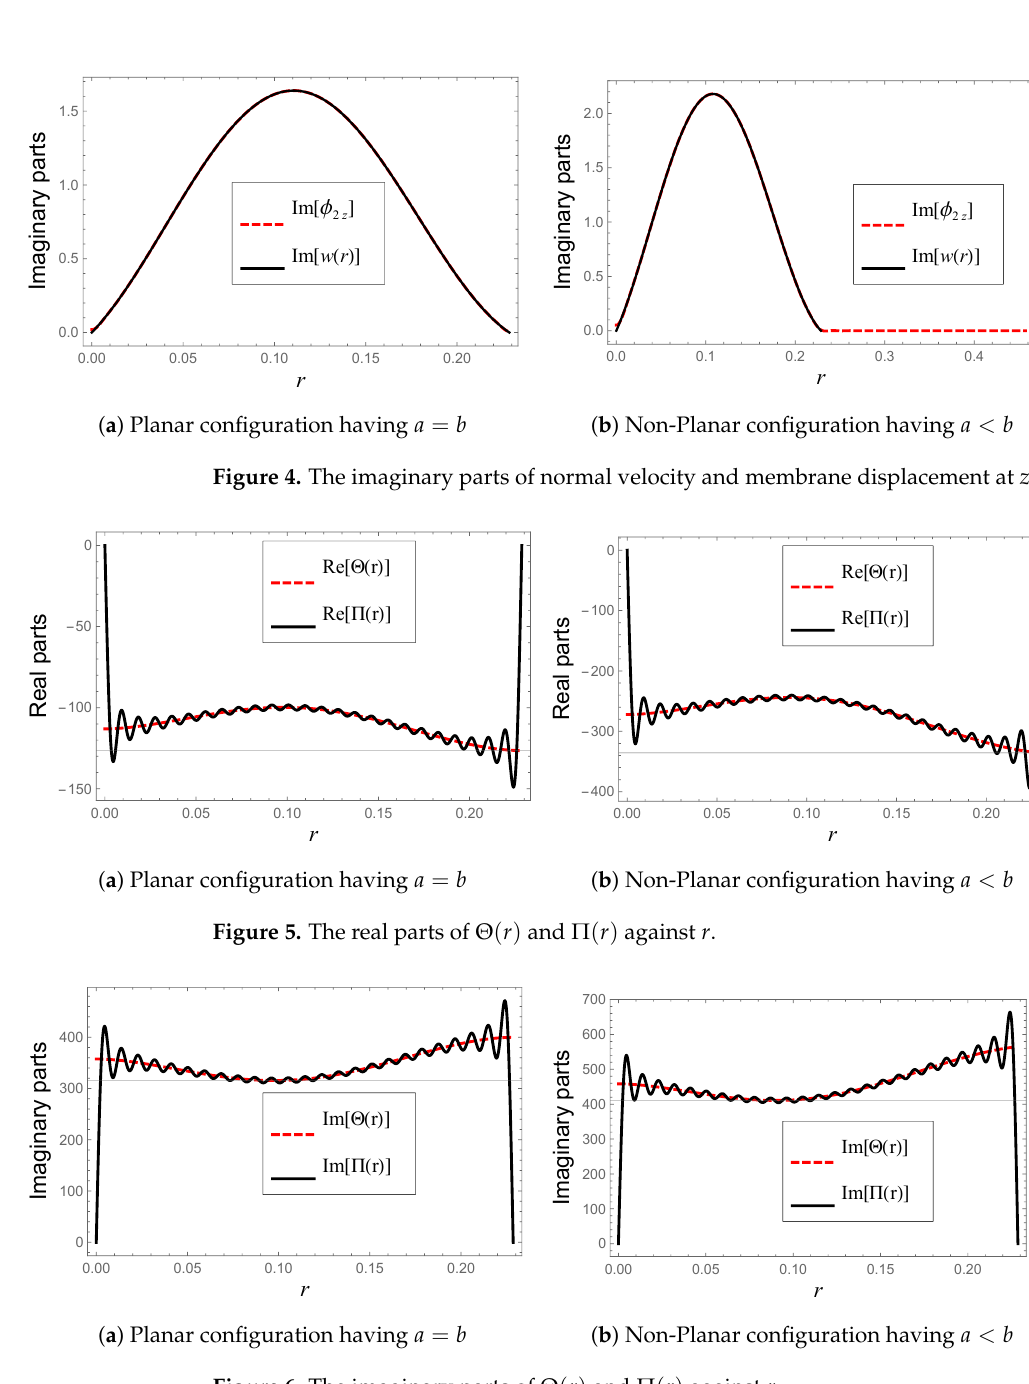
Figure 6. The imaginary parts of Θ ( r ) and Π ( r ) against r